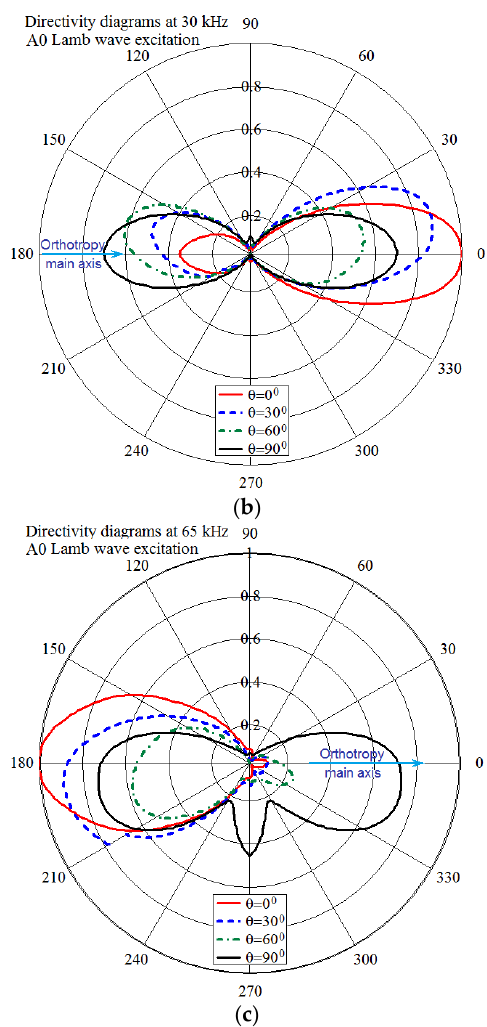
Figure 11. Variation of the A0 Lamb waves directivity with the wedge actuator’s angular orientation relative to the main axis of orthotropic symmetry of the CFRP plate at the excitation frequencies 15 kHz ( a ), 30 kHz ( b ), and 65 kHz ( c ).